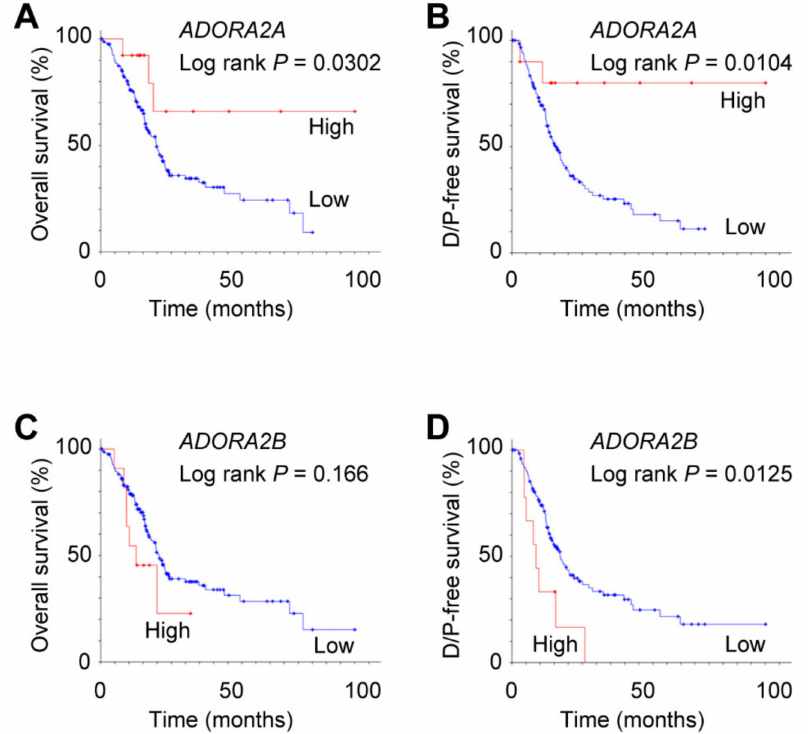
Figure 8. Association of mRNA expression of ADORA2A and ADORA2B with overall survival ( A , C ) and disease / progression (D / P)-free survival ( B,D ) in pancreatic adenocarcinoma patients. ( A ) High ( n = 13) and low ( n = 165) expression of ADORA2A ( P = 0.0302). ( B ) High ( n = 10) and low ( n = 128) expression of ADORA2A ( P = 0.0104). ( C ) Median survival time was 12.5 and 20.6 months with high ( n = 12) and low ( n = 166) expression of ADORA2B , respectively ( P = 0.166). ( D ) Median disease-free survival time was 8.5 and 17.1 months with high ( n = 10) and low ( n = 128) expression of ADORA2B , respectively ( P =